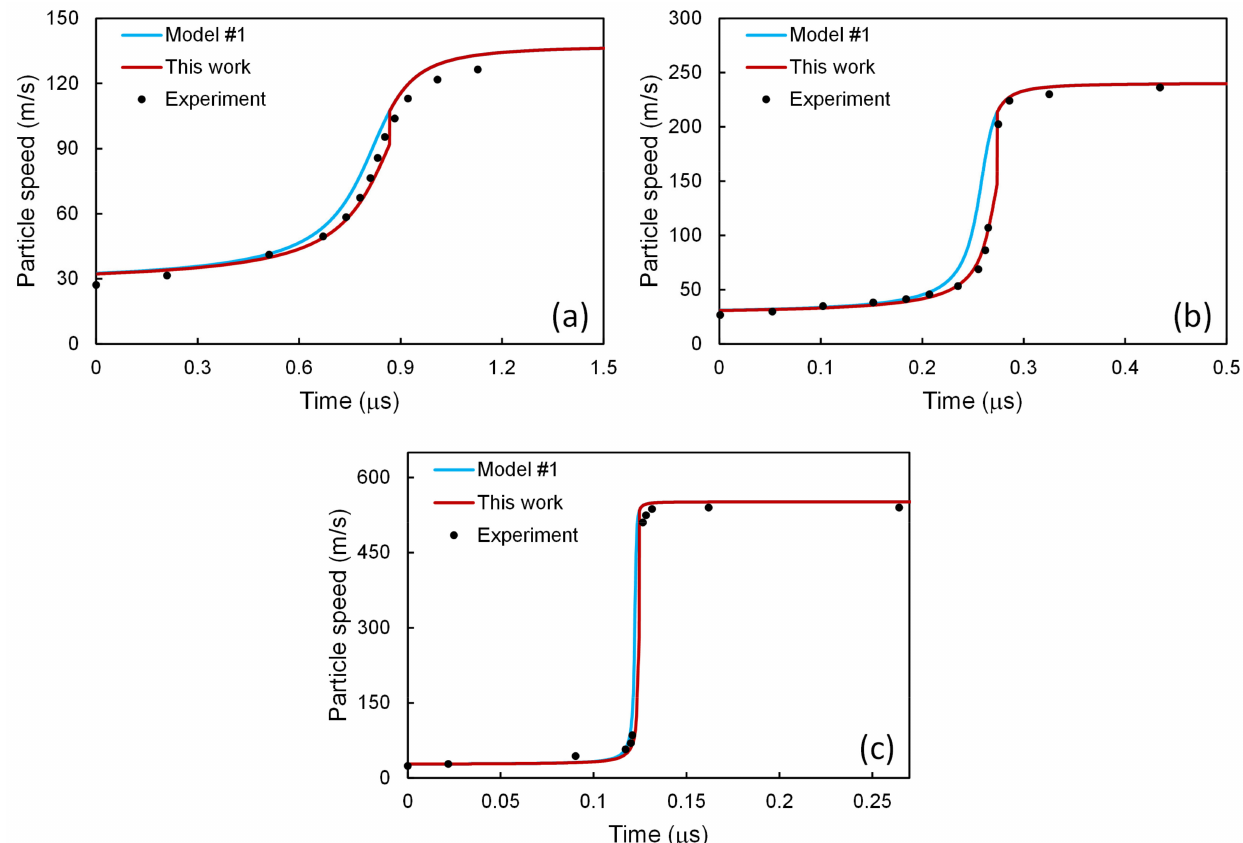
Figure 4. Particle speed profiles for 6061-T6 Al alloy at shock stress amplitudes of ( a ) 2.1, ( b ) 3.7, and ( c ) 9.0 GPa. The present scheme has been applied to model #1 [22], and the results are compared with those from model #1 [22] and the experimental ones